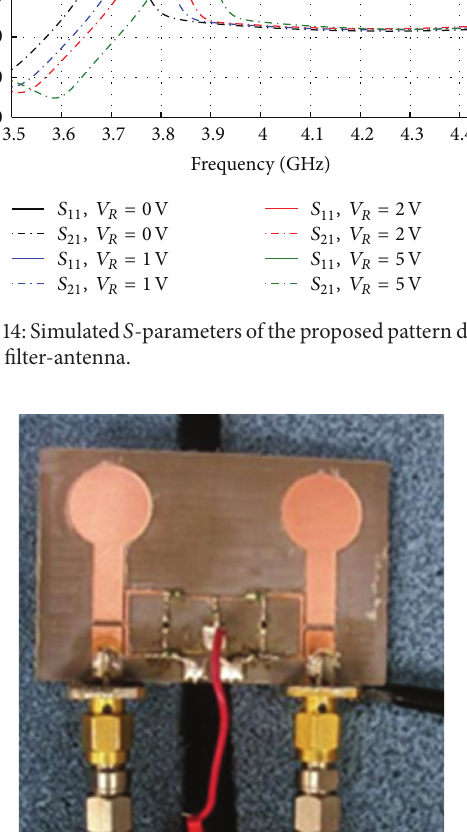
Figure 15: A fabricated prototype of the proposed pattern diversity tunable filter-antenna.